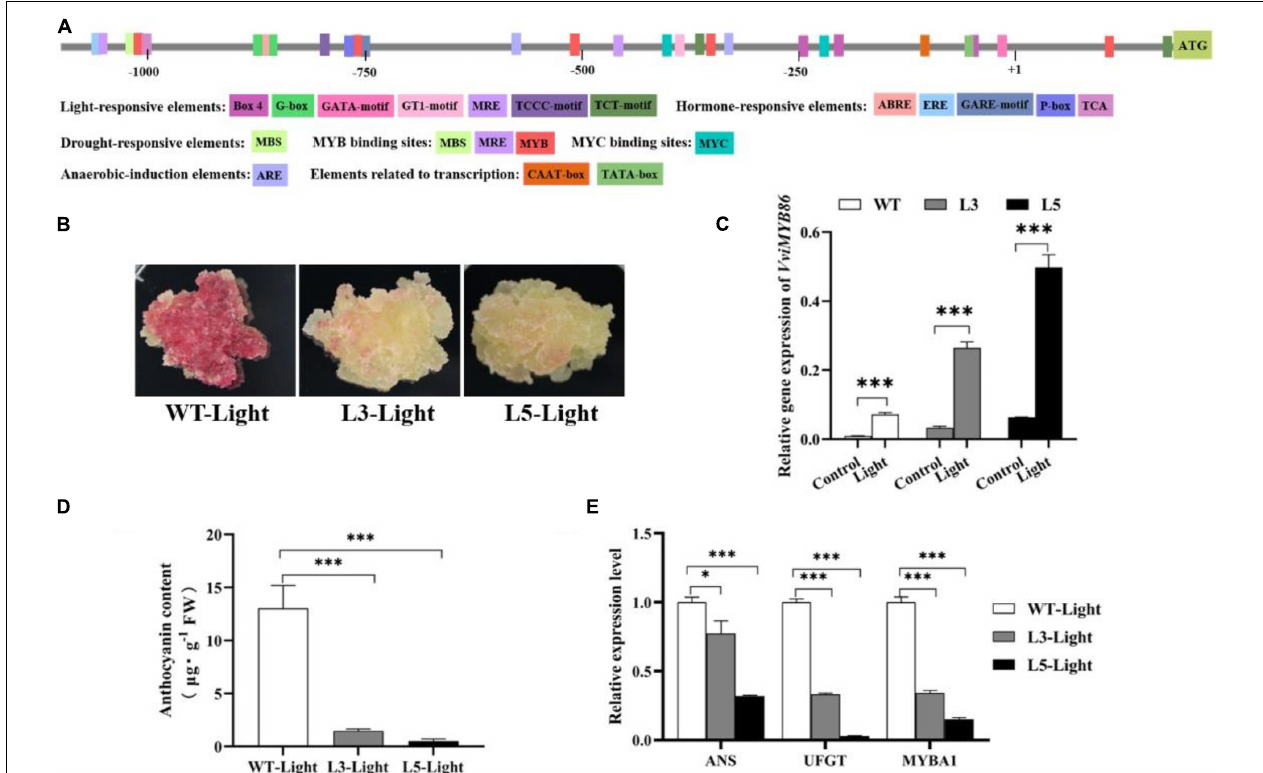
FIGURE 6 | VviMYB86 negatively regulated anthocyanin synthesis in grape callus. WT-Light, wild type callus cultured under light conditions; L3-Light, transgenic line 3 cultured under light conditions; L5-Light, transgenic line 5 cultured under light conditions. (A) The cis -acting elements present in VviMYB86 promoter predicted by PlantCARE website (http://bioinformatics.psb.ugent.be/webtools/plantcare/html/). (B) The nature status of WT callus and transgenic line 3 and line 5 under light conditions. (C) The expression levels of VviMYB86 in WT and transgenic calluses. Control: wild-type callus and transgenic calluses that cultured under dark conditions. Light: wild-type callus and transgenic calluses that cultured under light conditions. The value above the column referred to the transcripts of VviMYB86 in transgenic and WT calluses. (D) Anthocyanin contents in the WT callus and transgenic lines cultured under light conditions. The anthocyanin contents in callus samples measured by using the pH-differential method. FW, fresh weight. (E) Expressions of corresponding genes of anthocyanin biosynthesis pathway in the WT callus and transgenic lines cultured under light conditions. ANS, anthocyanidin synthase; UFGT, UDP-glucose: flavonoid-3- O -glucosyltransferase. Data was expressed as means ± SD of three replicates. Asterisks indicated significant differences relative to the control by one-way ANOVA test ( ∗ p < 0.05; ∗∗∗ p <